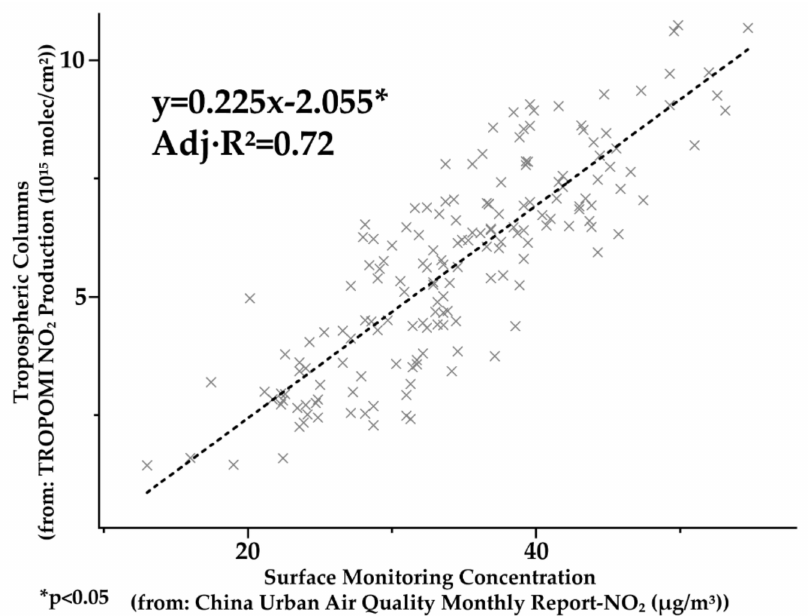
Figure 3. The linear regression between surface NO 2 monitoring concentration and TROPOMI tropospheric NO 2 column concentration. TROPOMI: TROPOspheric Monitoring